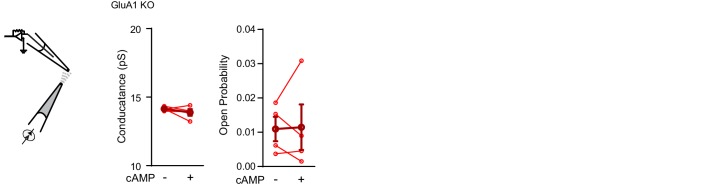
Cyclic AMP does not directly activate GluA2/3-receptor complexes.Conductance (left; paired t-test, p=0.4) and open probability (right; paired t-test, p=0.5) of somatic inside-out recordings from GluA1-KO CA1 neurons with S-AMPA (100 μM) in the recording pipette (n=4), before and after puffing cAMP (100 μM) onto the patch. Error bars indicate SEM.